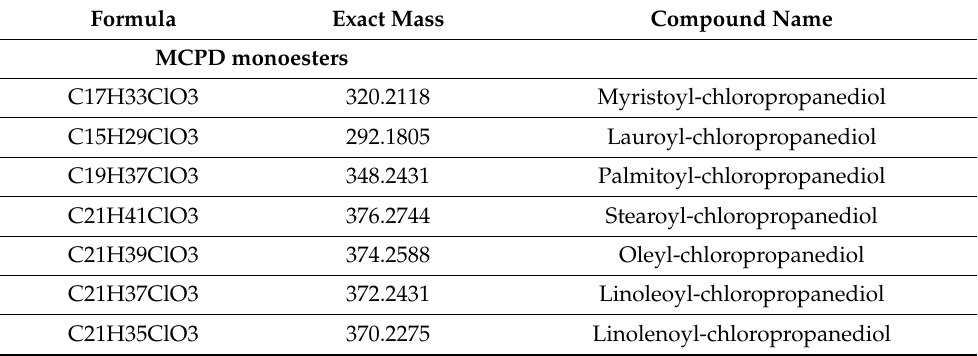
Table 2. Database of MCPDEs and